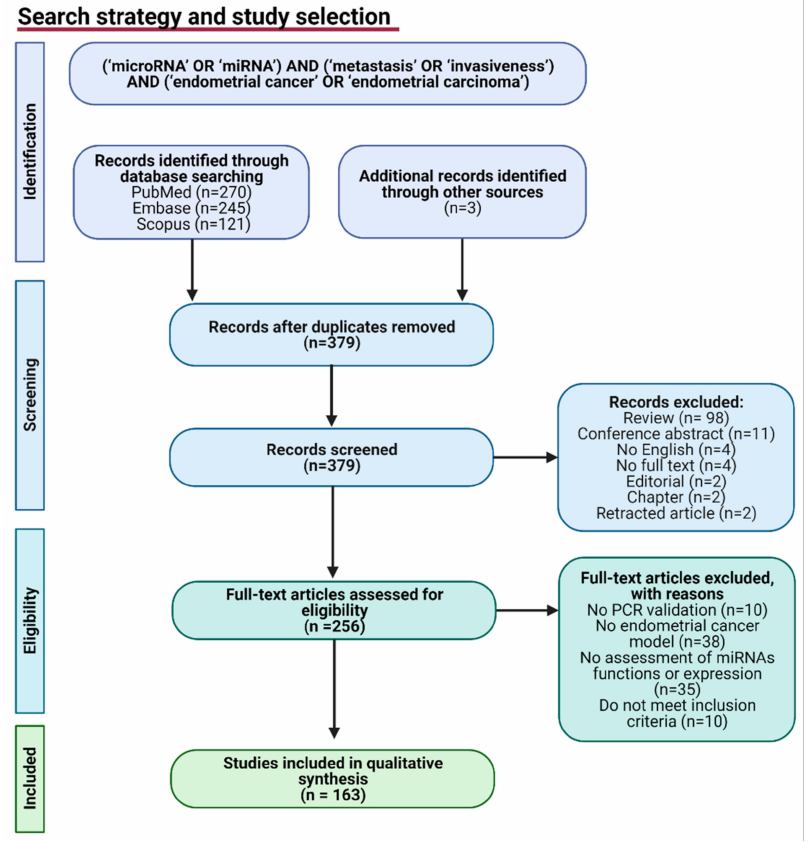
Figure 2. PRISMA flow-chart diagram of study selection. n = number of articles. Figure was created using Biorender.com.